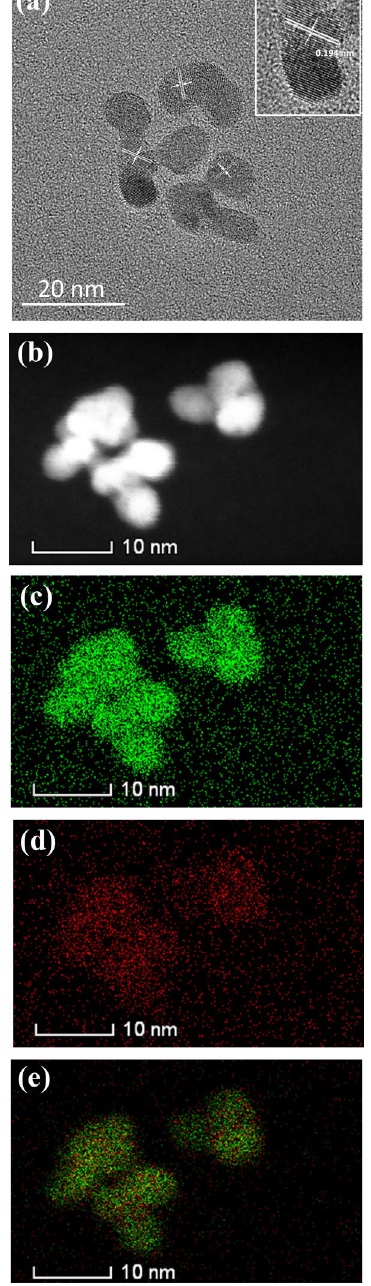
Fig. 1 a HRTEM image of the FePt NPs, b HAADF-STEM image of 3 FePt NPs, c STEM-EDX elemental mapping images showing the 3 distribution of Pt (green) (Pt K-edge), d STEM-EDX elemental map- ping images showing the distribution of Fe (red) (Fe K-edge), e merged image of the FePt NPs of the elemental distribution of Fe 3 (red) and Pt (green)